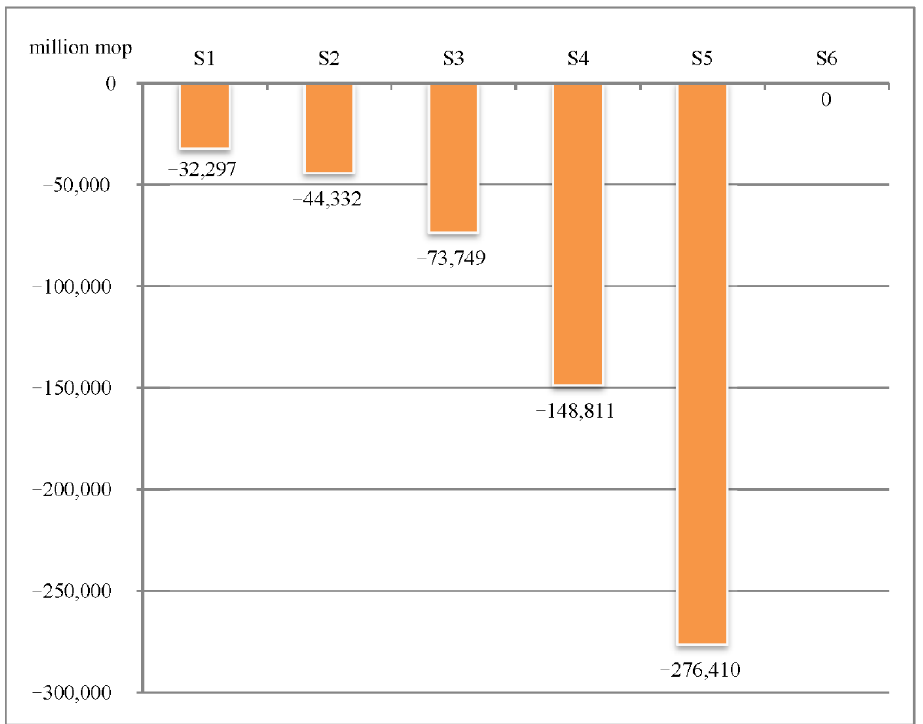
Figure 7. Loss of gross gaming revenue under six different management and control strategies.